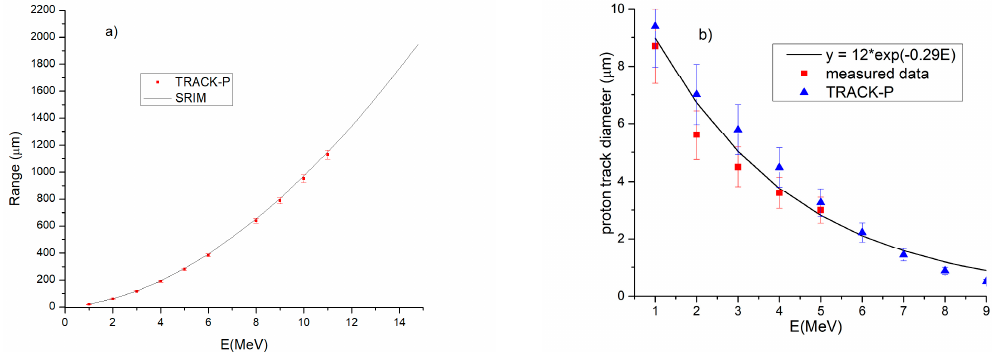
Figure 4. ( a ) Proton range calculated with SRIM 2013 and TRACK-P software; ( b ) The dependence of the proton track diameter on energy.